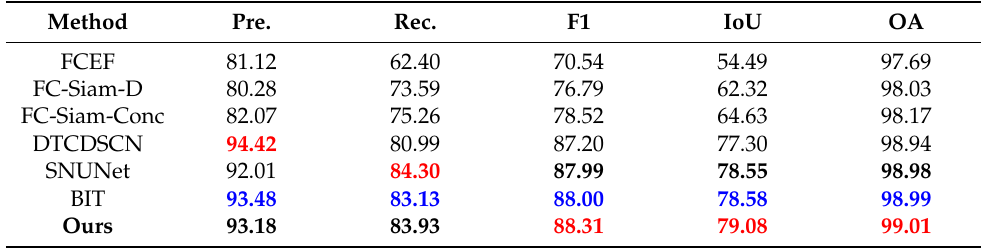
Table 6. The experimental results on the WHU-CD test sets *. Method Pre.